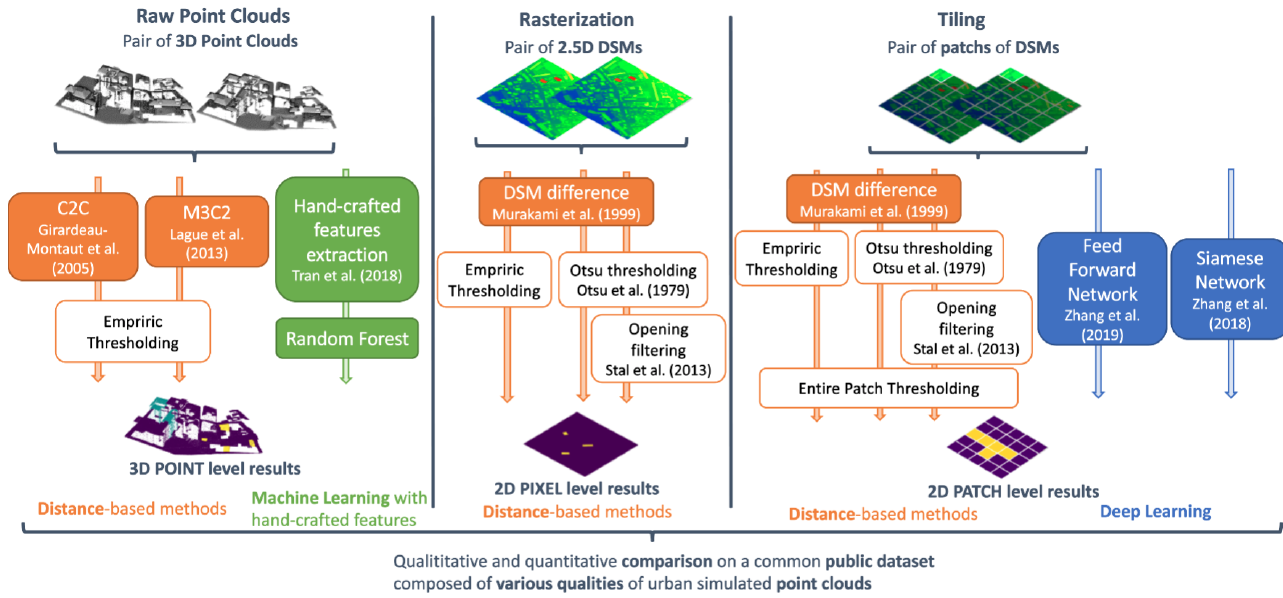
Figure 6. A presentation of the different state-of-the-art methods for change detection and characterization, considering three different levels of information: raw PCs, 2D rasterized PCs and patches of